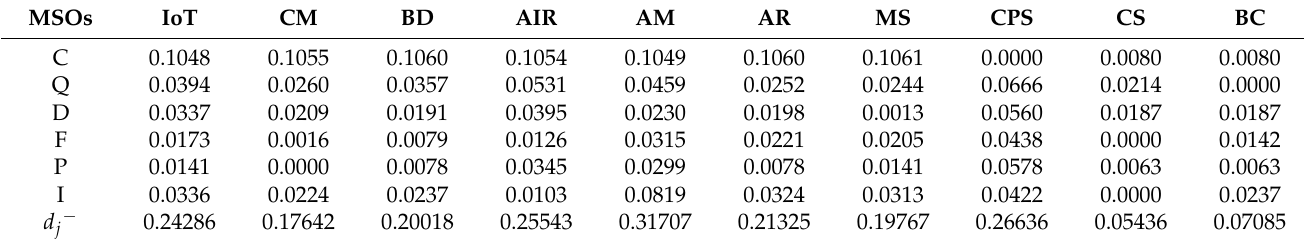
Table 10. Distance from fuzzy negative ideal solution (FNIS).